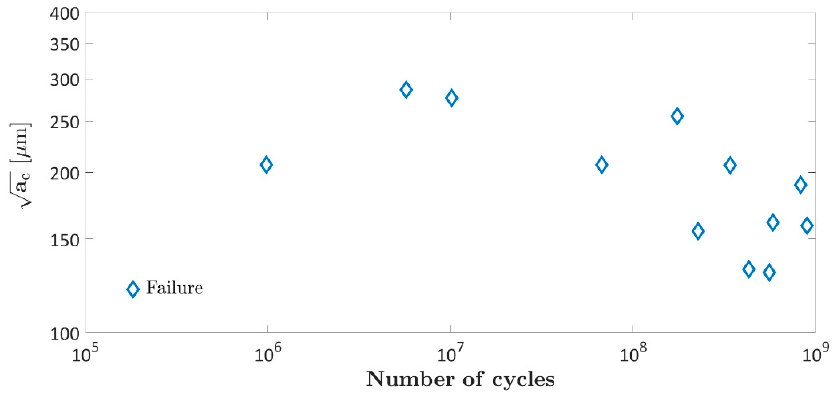
√ Figure 6. Defect size (cid:3493)𝑎 (cid:3030) , with respect to 𝑁 (cid:3033) . Figure 6. Defect size a c , with respect to N f Figure 6. Defect size (cid:3493)𝑎 (cid:3030) , with respect to 𝑁 (cid:3033) .